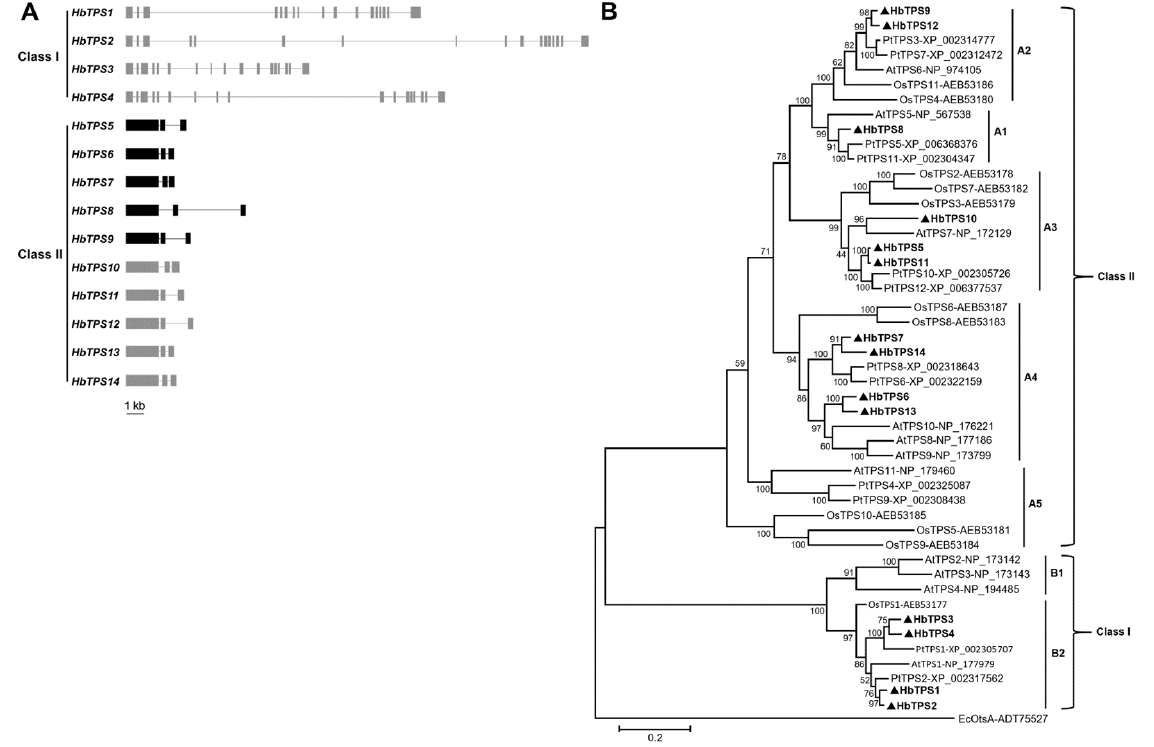
Figure 1. Exon–intron structure of the fourteen HbTPS genes ( A ) and their protein phylogeny ( B ). ( A ) Exons are shown by solid boxes and introns by solid lines. The genomic structures represented by gray boxes and lines were predicted using the Hevea genome draft sequence, whereas those in black boxes and lines were further confirmed by PCR cloning and sequencing. ( B ) The tree is constructed by using MEGA version 6.0 with 48 plant TPS proteins that include 11 in Arabidopsis thaliana, 11 in Oryza sativa, 14 in H. brasiliensis, and 12 in Populus trichocarpa, and the E. coli otsA as an outgroup. The fourteen HbTPS proteins are highlighted with black triangles.